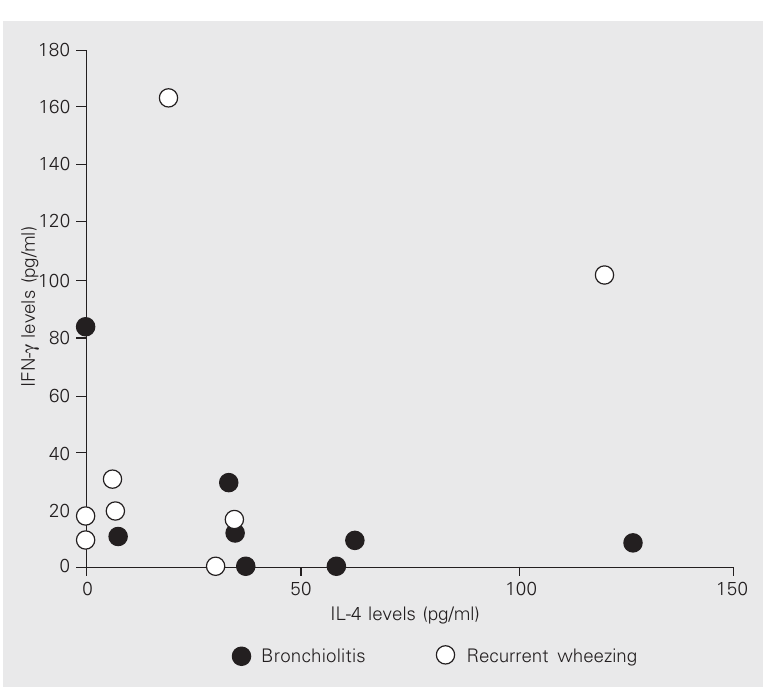
Figure 1. Relationship between IFN- γ and IL-4 levels in nasopharyngeal aspirate from infants with acute bronchiolitis and recurrent